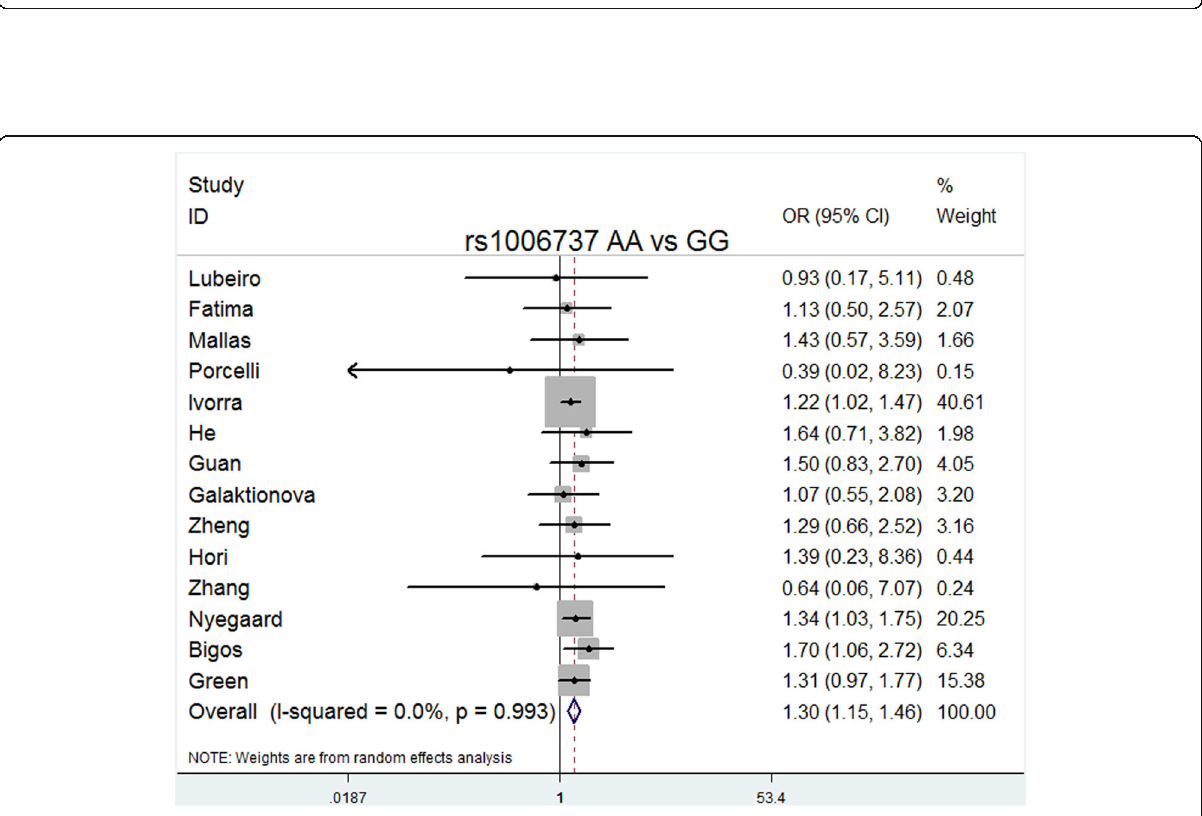
Fig. 5 Forest plot of the complete codominance model (AA vs. GG) for rs1006737. Significant differences between rs1006737 and the risk of schizophrenia were observed with the codominance model (AA vs. GG) (OR = 1.296, 95% CI = 1.151 – 1.459, P heterogeneity = 0.993, P =